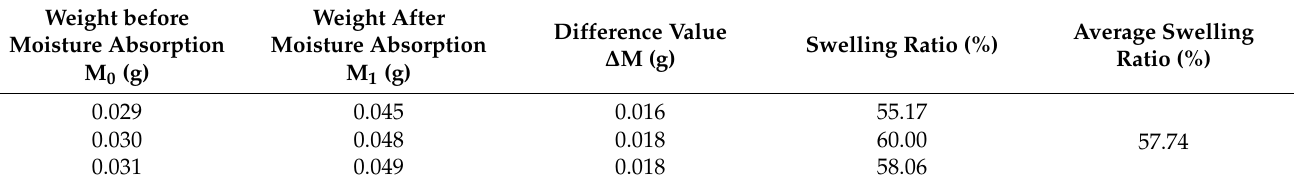
Table 1. Swelling ratios of PN@8 wt%Ag-NCS (control group).